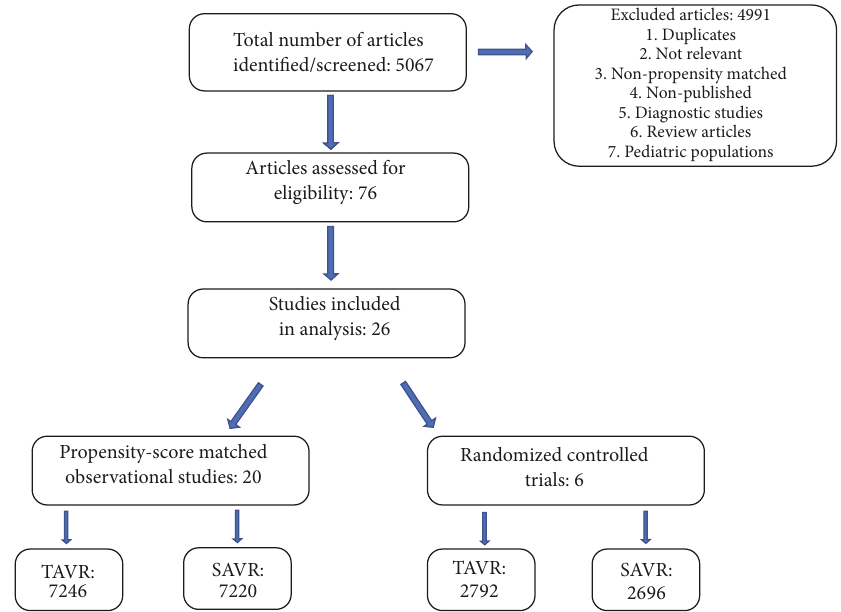
Figure 1: Flow chart of the meta-analysis. TAVR: transcatheter aortic valve replacement, SAVR: surgical aortic valve replacement.